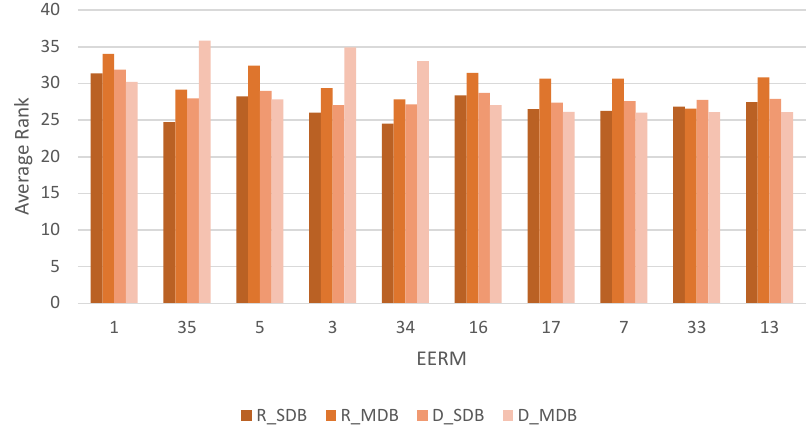
Figure 3. Ranking of alternative per building combo . 1: Maintenance_Wall, 35: Maintenance_Enve- lope + New _EnergyGeneration, 5: Upgrade_Wall, 3: Maintenance_Roof, 34: Maintenance_Enve- lope + Upgrade_EnergyGeneration, 16: New element_EnergyGeneration, 17: New element_Ener- gyStorage, 7: Upgrade_Roof, Upgrade_Envelope + New _EnergyGeneration, 33: Upgrade_Enve- lope + New _Energy generation, 13: New element_Ventilation.